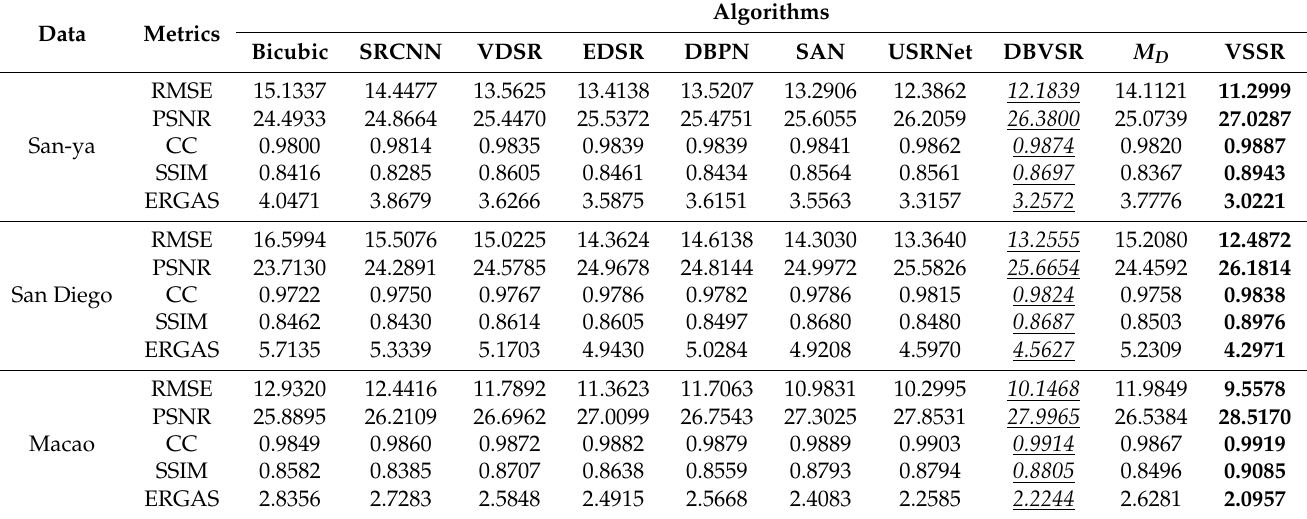
Table 2. Quantitative evaluation of the proposed VSSR against different methods on the Jilin- 1 data with scale factor of 4, Bold indicates the best and italic underline indicates the second- best